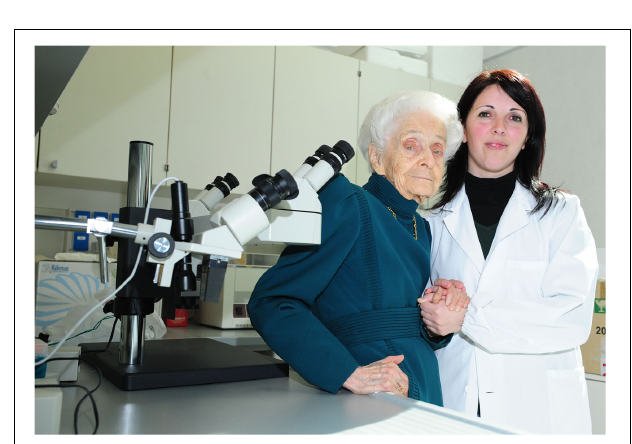
FIGURE 3 | Annalisa Manca and Rita Levi-Montalcini close to the microscope with two oculars [Photographer Maurizio Riccardi (Agr Press) from EBRI Media